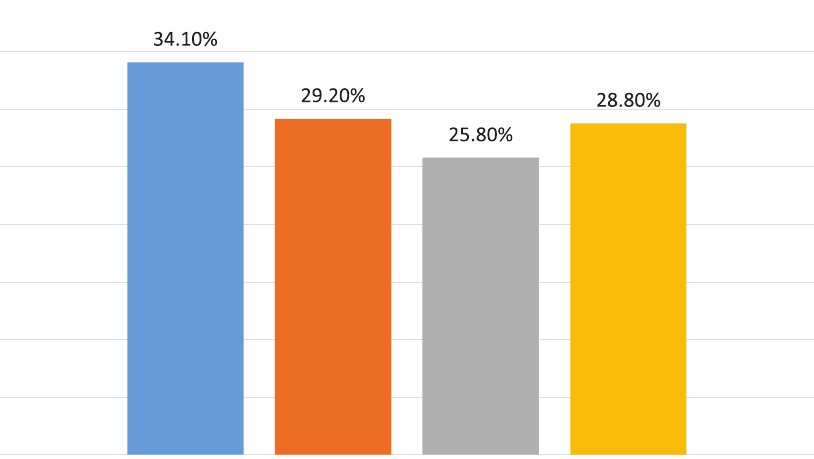
Figure 4. Vulnerability to disinformation and encountering agreeing information in social media. Notes: Blue stands for the statement “you like it and share it,” orange for “you check who posted it,” grey for “you share to a close friend group,” and yellow for “you check whether the information is true or